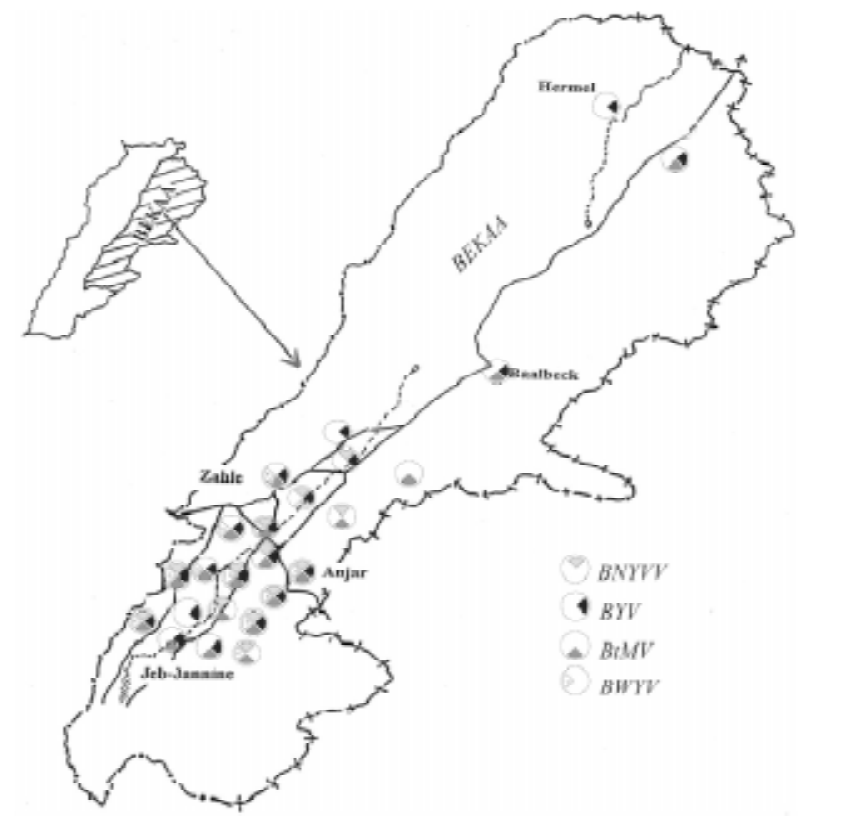
Fig. 1. Distribution of virus diseases on sugar beet in